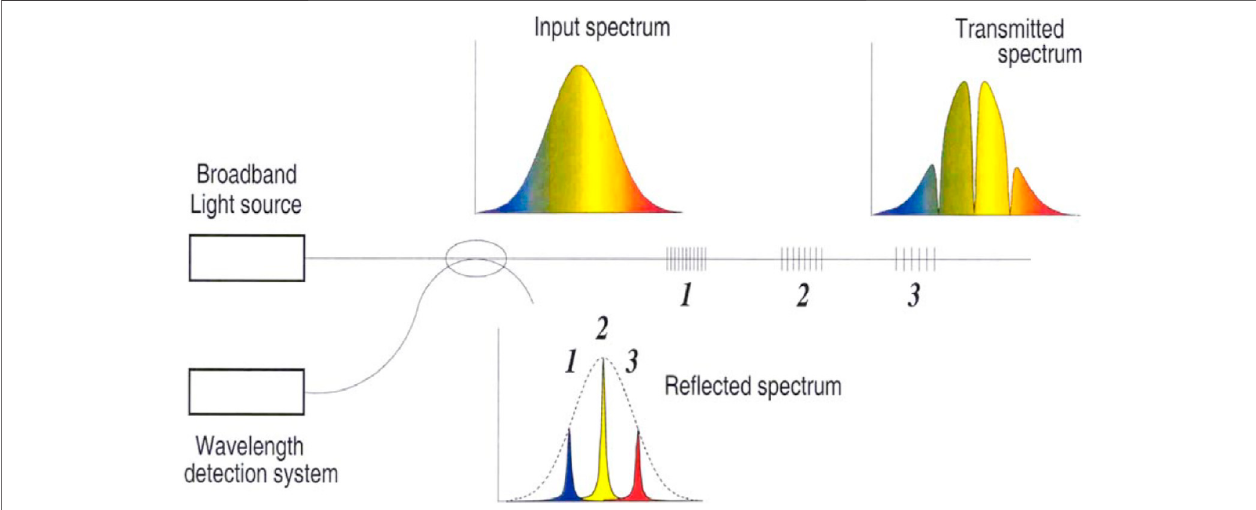
FIGURE 2 | An example of an FBG based sensing system showing the Spectra of the FBG in re fl ection and transmission.